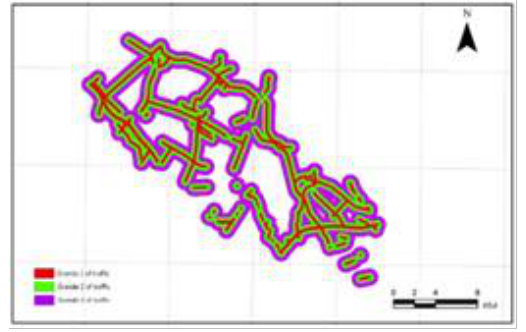
Figure 5 Pidu District Traffic